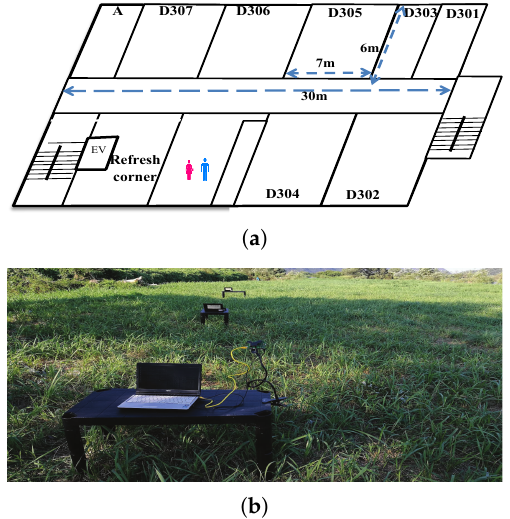
Figure 1. Experiment fields. ( a ) Indoor environment. ( b ) Outdoor environment.